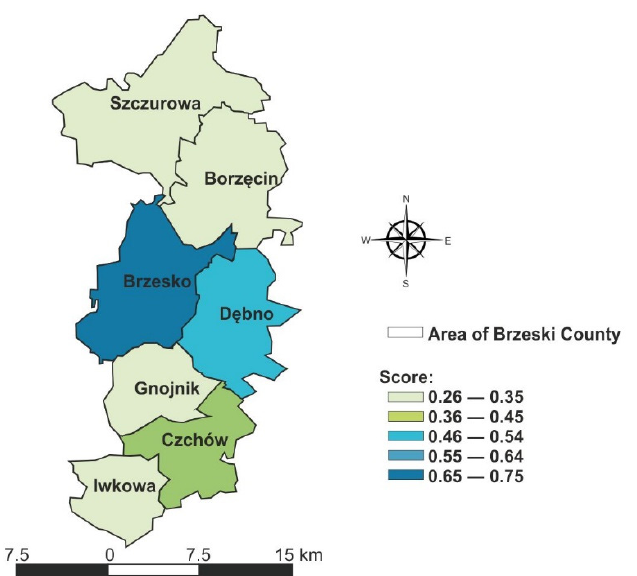
Figure 7. The communes’ overall composite score in terms of general conditions conducive to the development of tourism.